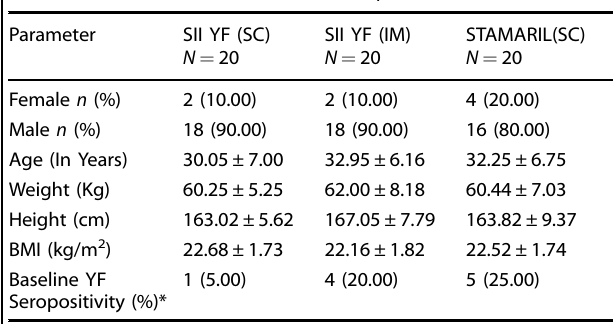
Fig. 1 Flow diagram of trial participants. Screening, randomization and follow-up of enrolled participants. Twenty participants were randomized to each group. All participants received a single dose of the study vaccine as per allocated vaccine group. Nineteen participants in each group completed the Day 90 follow-up. Table 1. Baseline Characteristics of